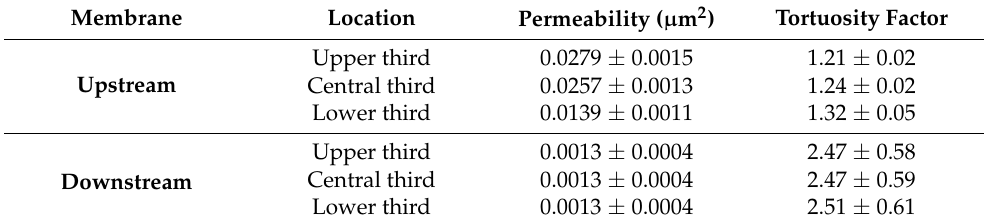
Table 1. Simulated permeability and tortuosity values. Permeability was determined using Avizo XLab and Tortuosity Factor using the Taufactor plugin for Matlab. Results are reported to three significant figures and one standard